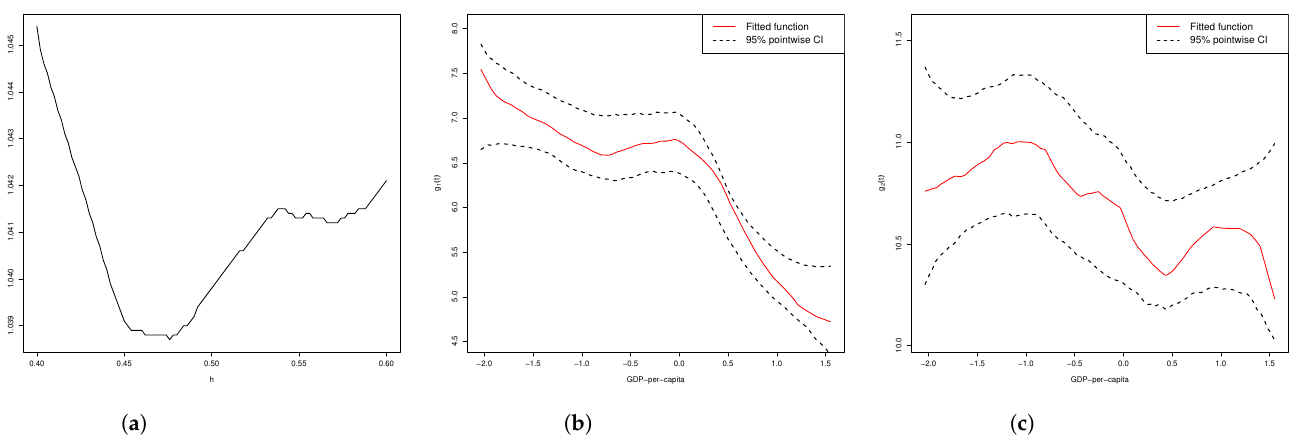
Figure 5. Fitted model: ( a ) The GCV plot over a range of bandwidths with a minimum at h = 0.475. ( b ) Estimated non-parametric function (red solid lines) ˆ g 1 ( t ) and ( c ) estimated non-parametric function (red solid lines) ˆ g 2 ( t ) . The dashed lines are the 95% point-wise confidence